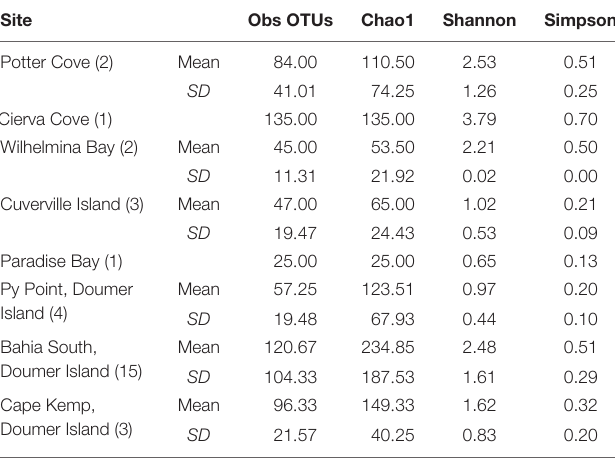
TABLE 1 | Diversity measures of the microbial communities recorded in samples of Mycale ( Oxymycale ) acerata collected at sites along the WAP. Site Obs OTUs Chao1